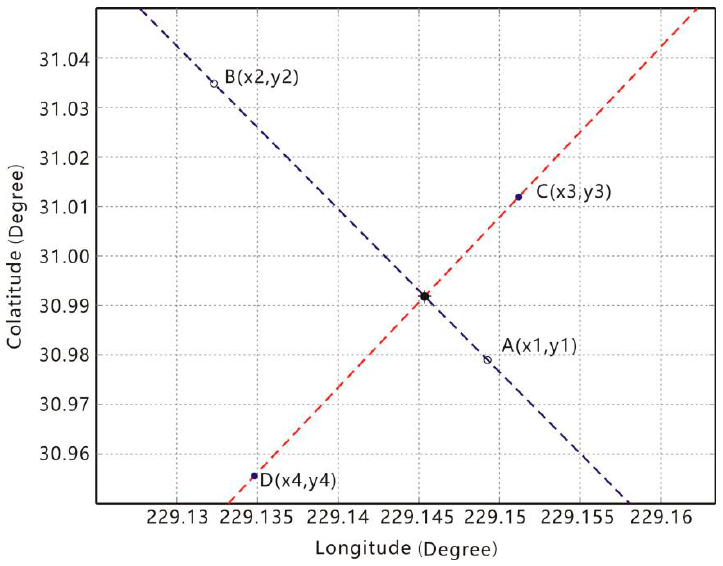
Figure 1. Crossover point for computing vertical deflections.